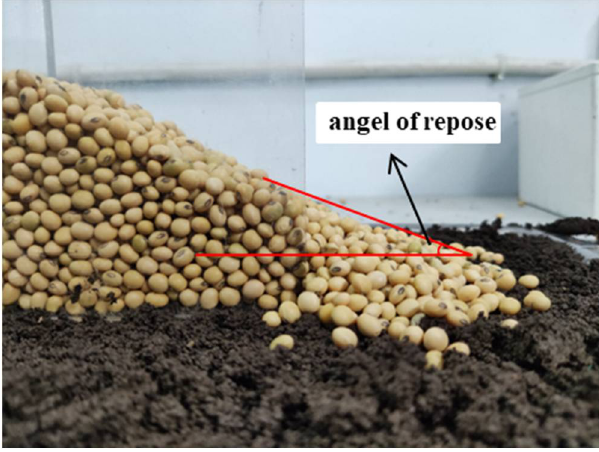
Figure 2. Piling test device.